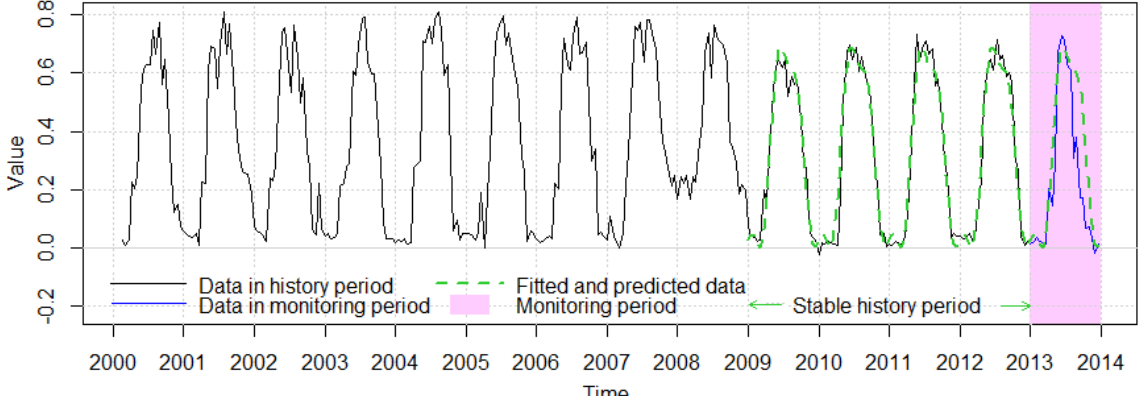
Figure 1. Illustration of segmenting and modelling a time series data before 2013 and forecasting data in 2014 with season-trend model.